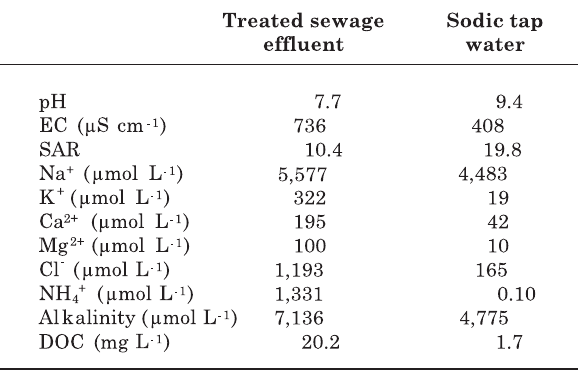
EC: electric conductivity; SAR: sodium adsorption value; DOC: dissolved organic